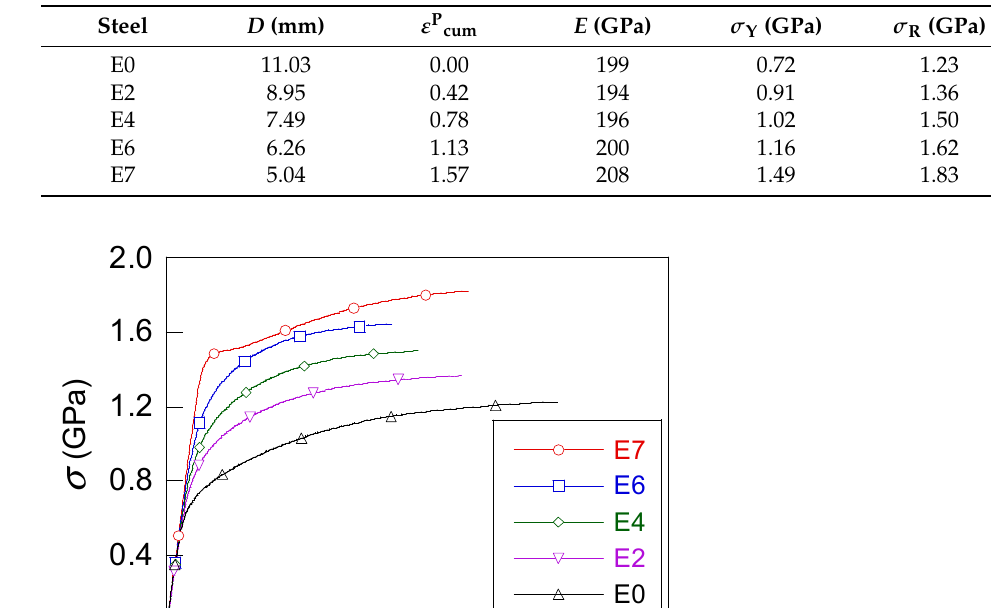
Table 2. Dimensions and mechanical properties of the steels analyzed.